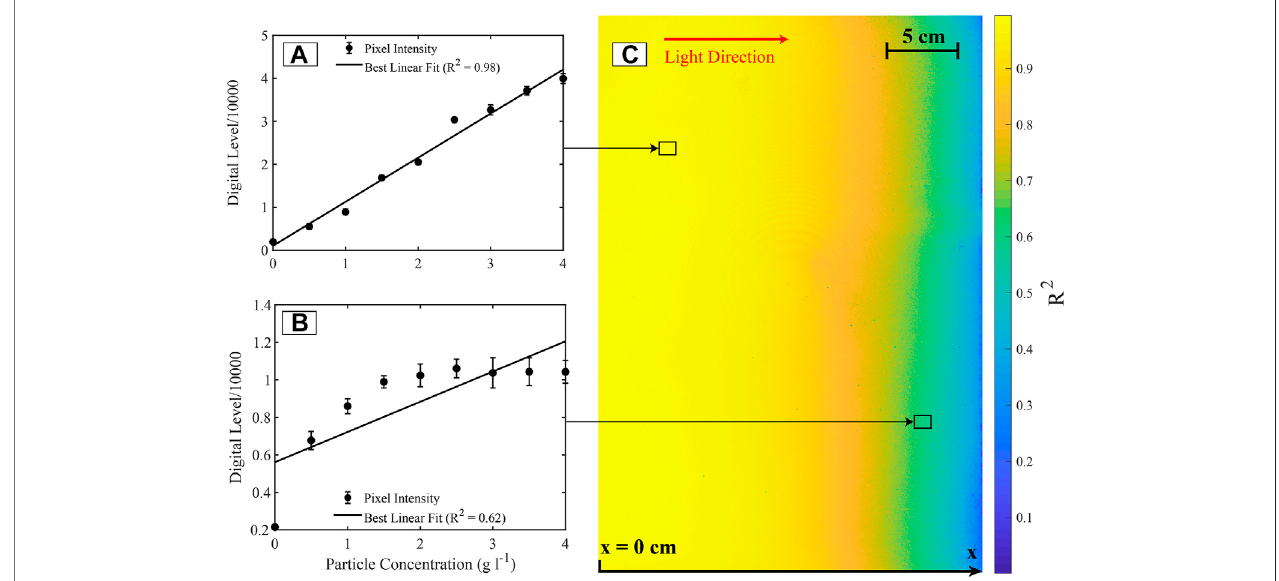
FIGURE 3 | Calibration of the particle concentration for a laser power of 0.50 W. (A) Example of a linear relationship between particle concentration and the light intensityinonepixel.Inthisexample,the coef fi cient ofdetermination R 2 suggests averygoodlinear fi t. (B) Exampleofapixelwithalow-quality linearregression. Vertical error bars in panels A and C represent the standard deviation of the averaged pixel digital level over 10 s. (C) Map of R 2 inside the tank. R 2 diminishes as a function of x (distance from the wall closest to the laser).